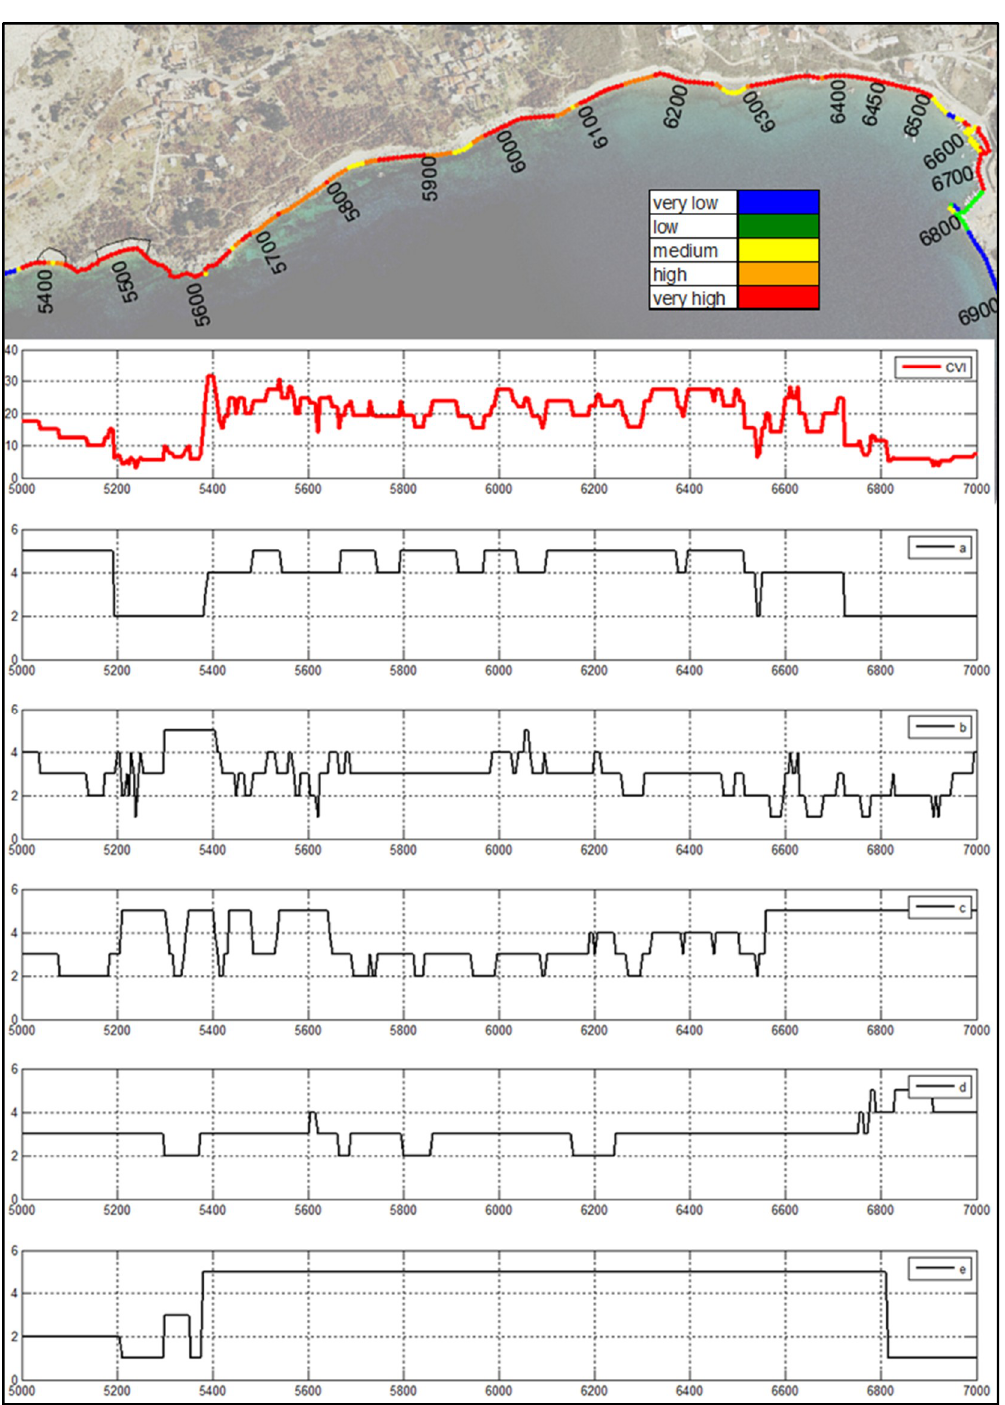
Figure 11. The results of the vulnerability assessment around the urbanized area of Stara Baška: total CVI index; ( a ) Geological fabric; ( b ) Coastal slope; ( c ) Emerged beach width; ( d ) Significant wave height; (e) Land use.